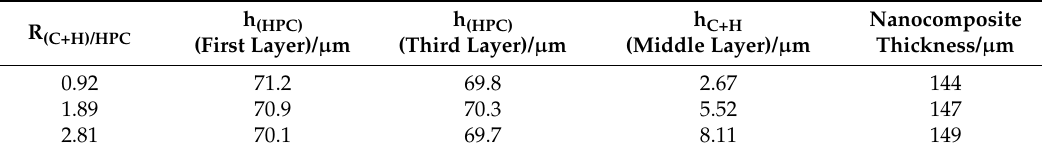
Table 3. The thicknesses of the films, the outer HPC layers, and intermediate chitosan/HNT layer for